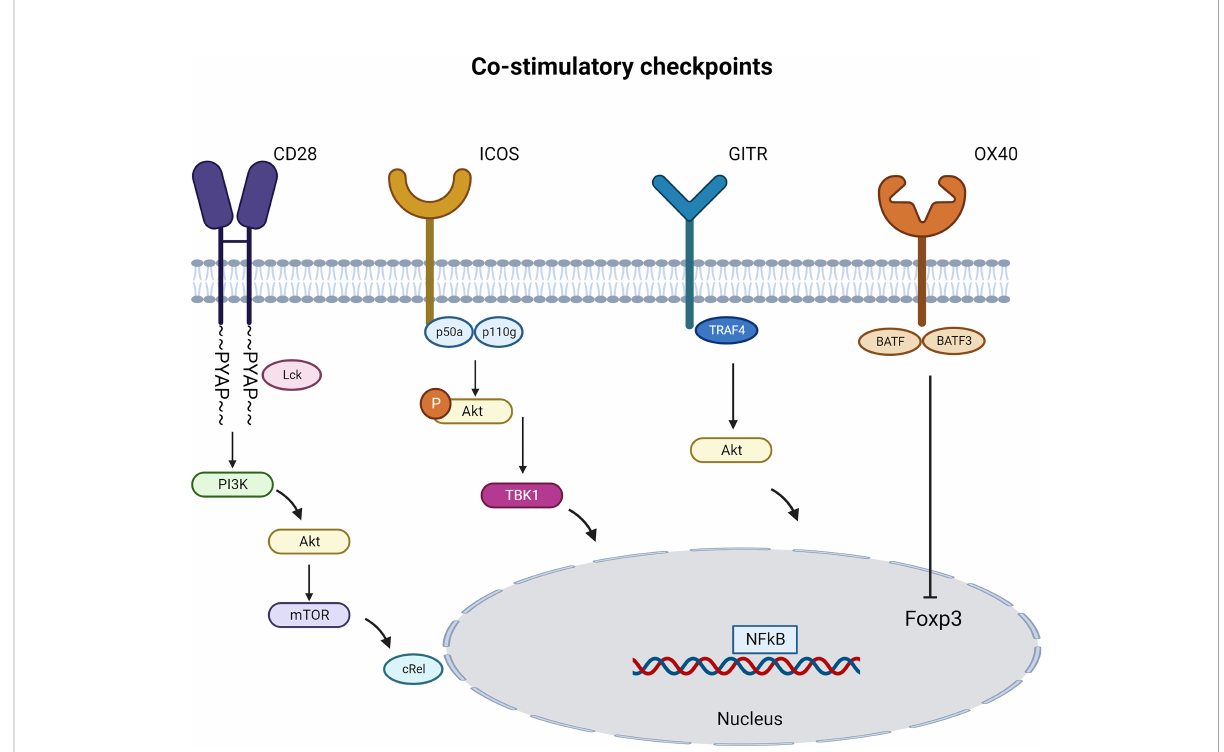
FIGURE 3 Immune Co-stimulatory signaling pathways speci fi c to Tregs. Immune co-stimulatory checkpoints signaling are described in different cell types but only some are detailed in Tregs. The fi gure represents the most studied pathways. (Created with